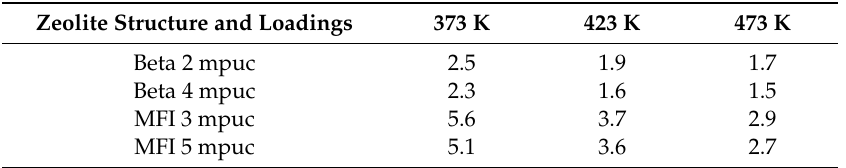
Figure 3. The radial distribution function and its integration for *O m -H a showing H-bonding between the acid site and methanol as a function of temperature in H-Beta for loadings of ( a ) 2 and ( b ) 4 mpuc, and in H-MFI for loadings of ( c ) 3 and ( d ) 5 mpuc. Table 2. Residence times τ obtained after the exponential fit of the contact correlation function C(t) at 373, 423 and 473 K.